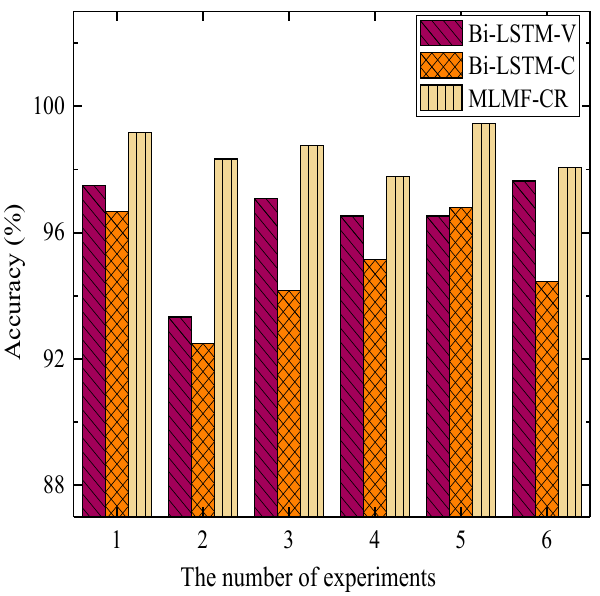
Figure 8. Fault diagnosis accuracy under different information